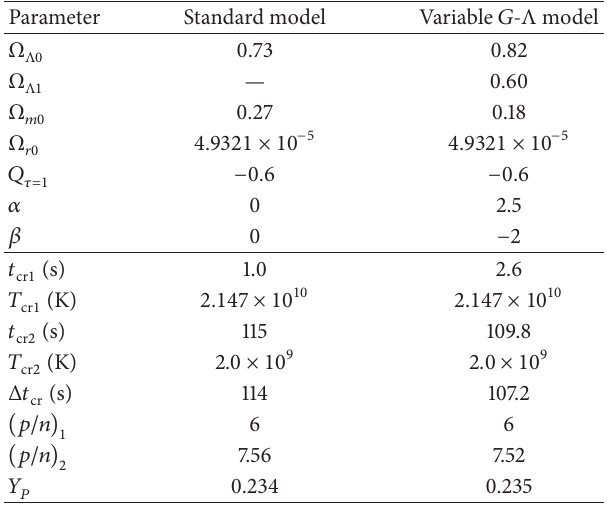
Table 1: The value of various cosmological parameters in the two